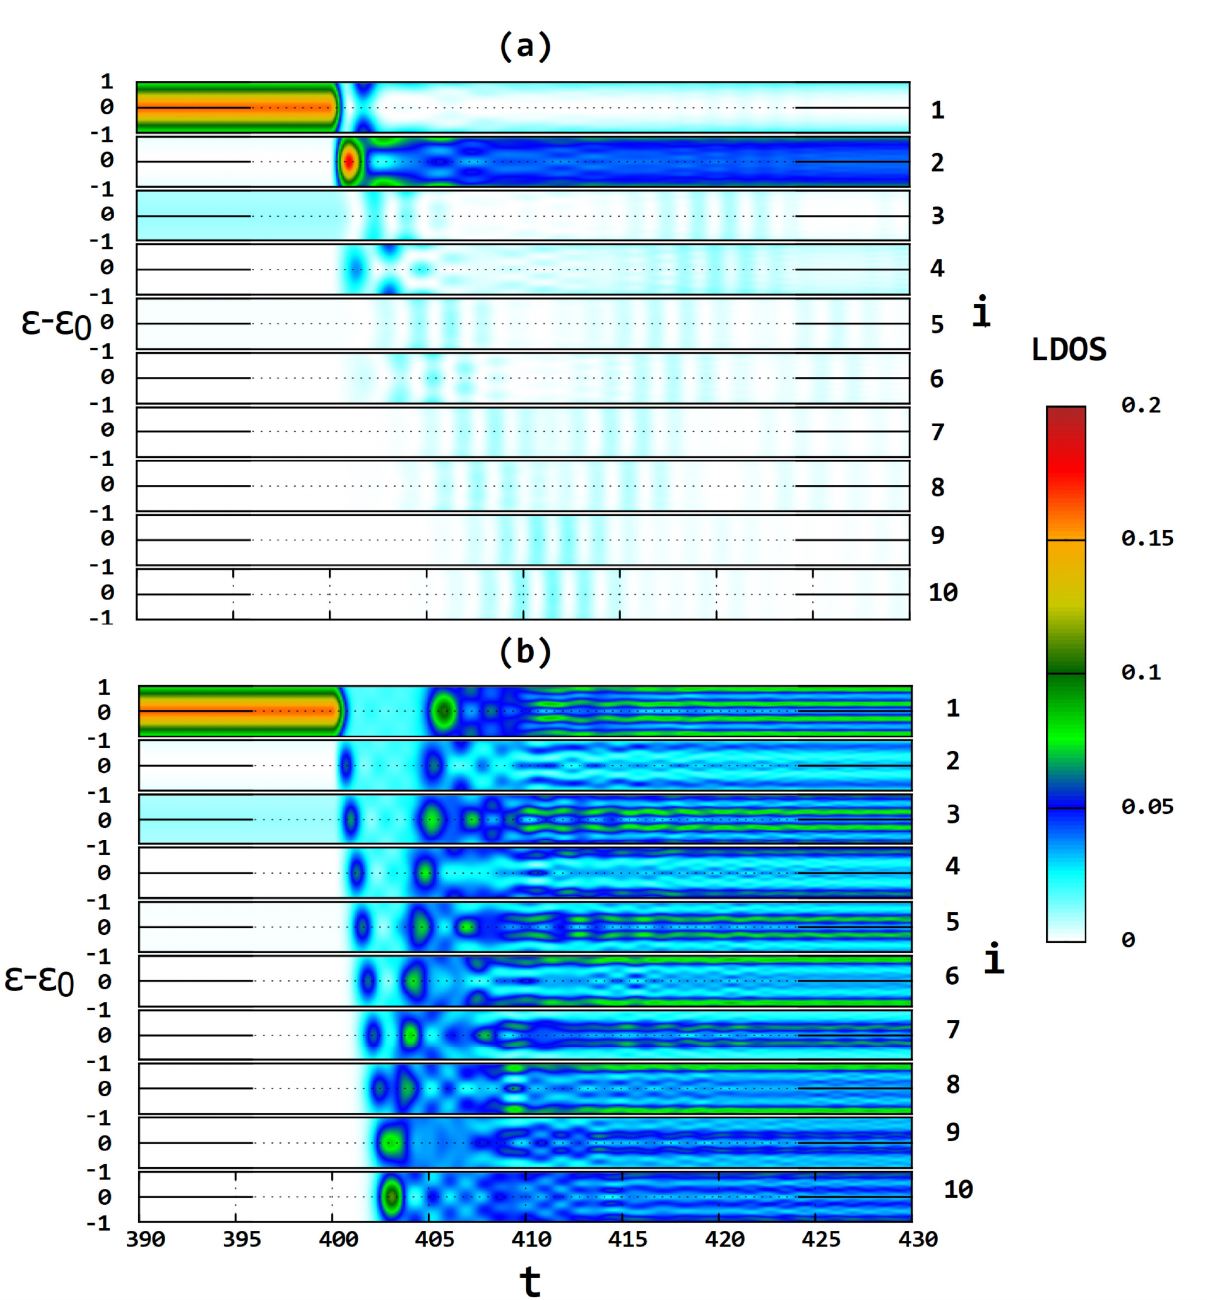
Figure 5. LDOS time evolution at first 10 sites in the topologically nontrivial chain, SSH 1 ( V = 0.5, W = 2) quenched to the trivial chain SSH 0 [ V = 2, W = 0.5, panel (a)] or to the normal chain [ V = W = 2, panel (b)] at t = 400. The chain length is N = 20 and the on-site energies ε 0 =